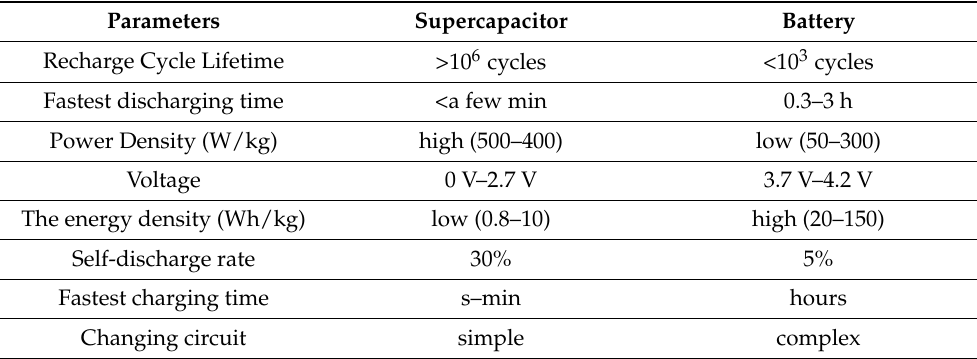
Table 6. Power storage comparation. Adapted from Ref. [30].